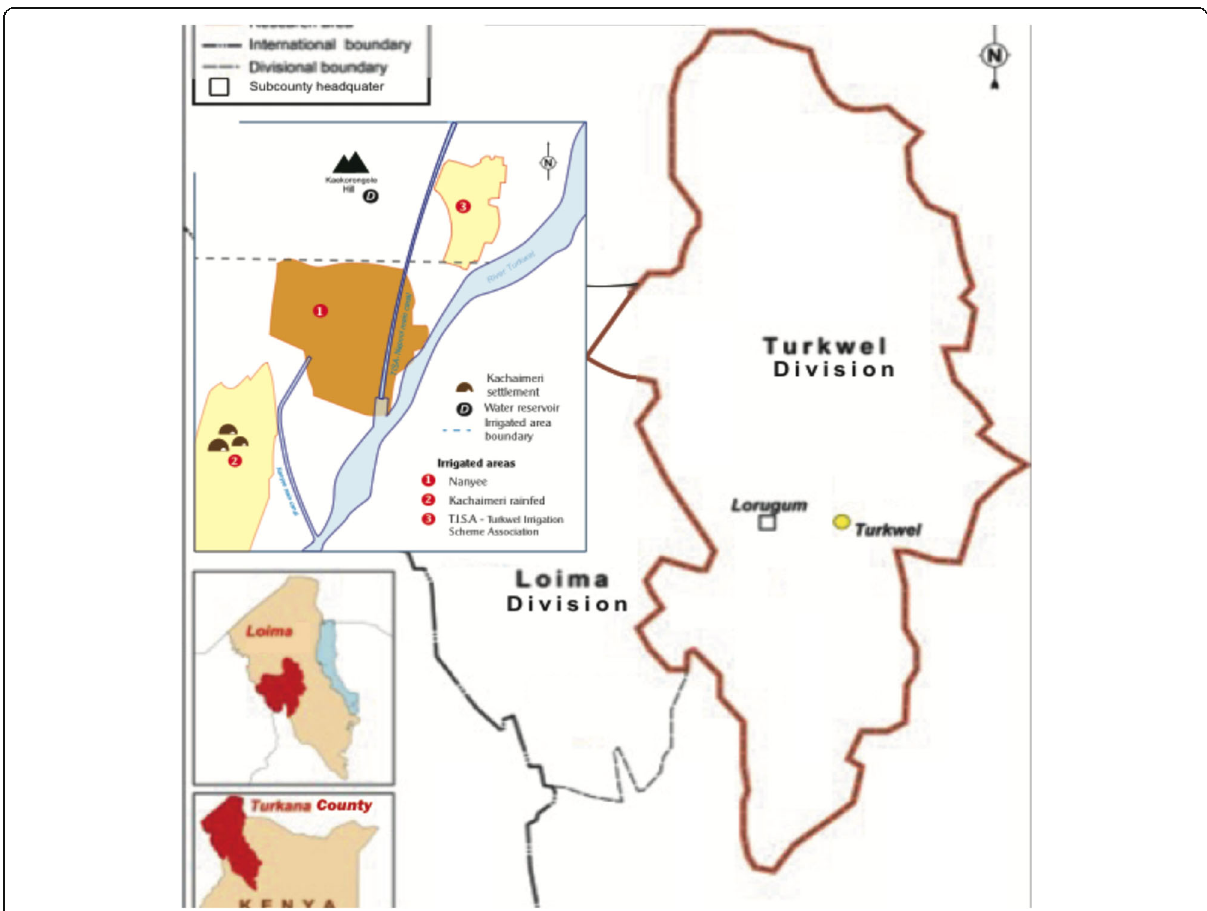
Fig. 2 Location of the study area in Loima sub-County,